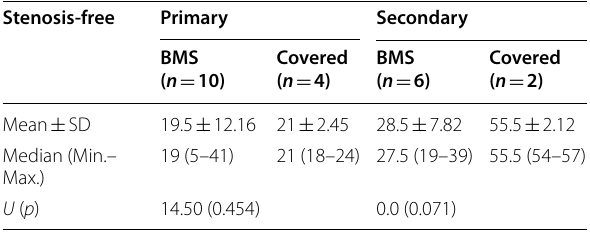
Table 4 Comparison between BMS and covered according to stenosis-free